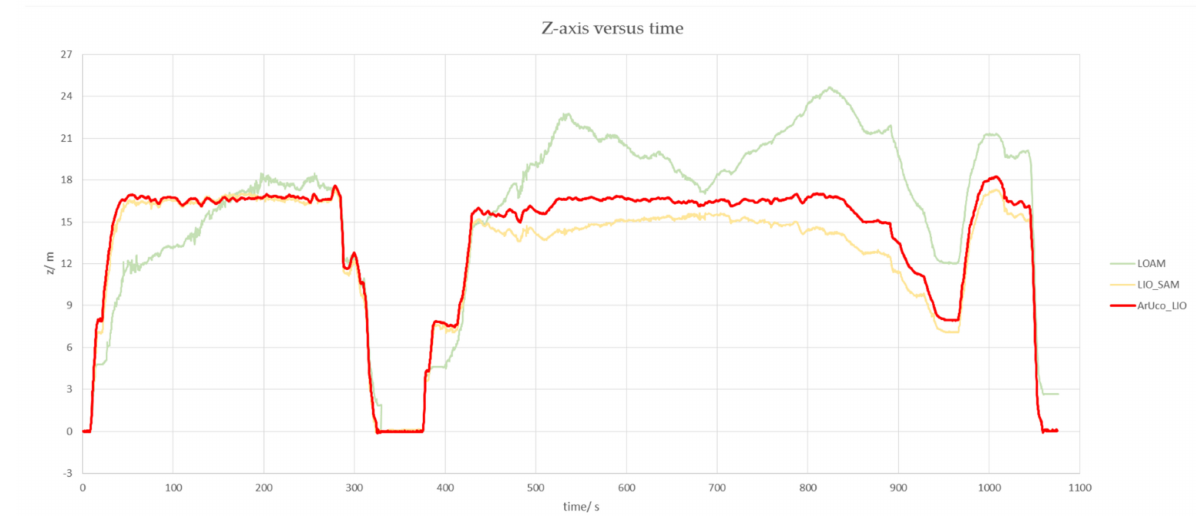
Figure 12. The z-axis variation curve with